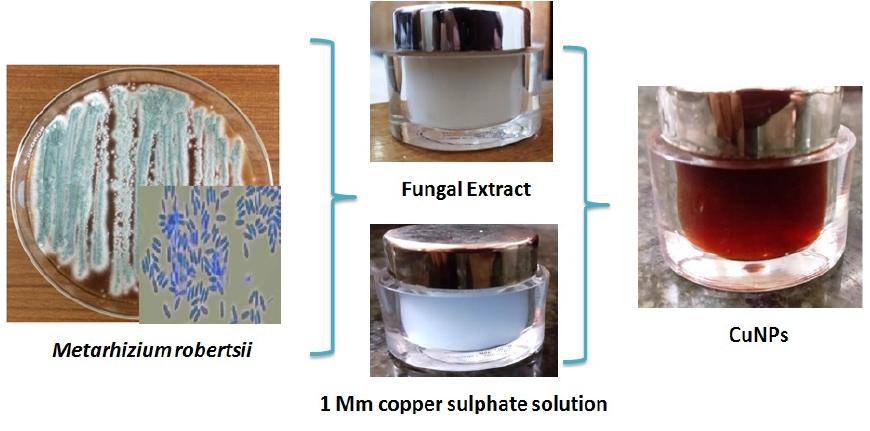
Figure 3. Synthesis process of copper sulphate nanoparticles.